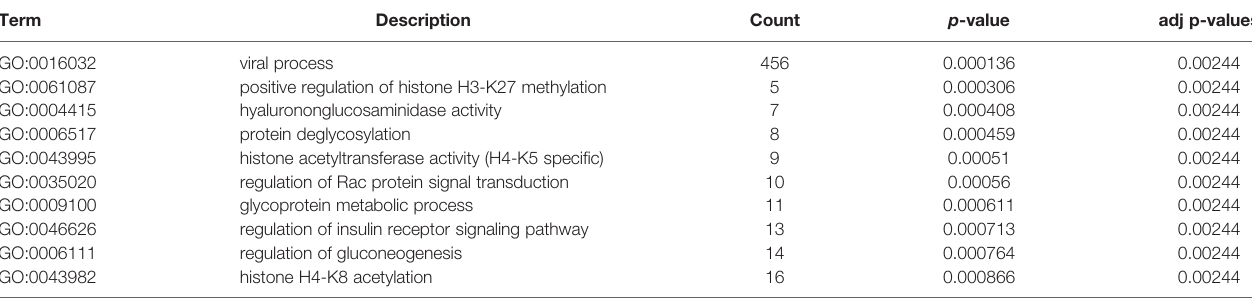
TABLE 1 | GO analysis of OGT/OGA associated genes with ovarian cancer.